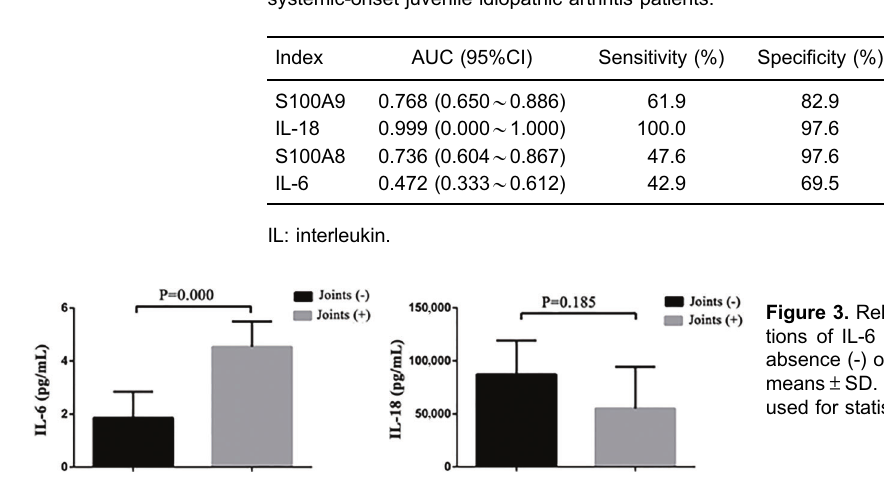
Table 3. Area under the receiver operating characteristic (ROC) curve (AUC), sensitivity and speci fi city of S100A9, IL-18, S100A8, and IL-6 in predicting systemic-onset juvenile idiopathic arthritis patients.